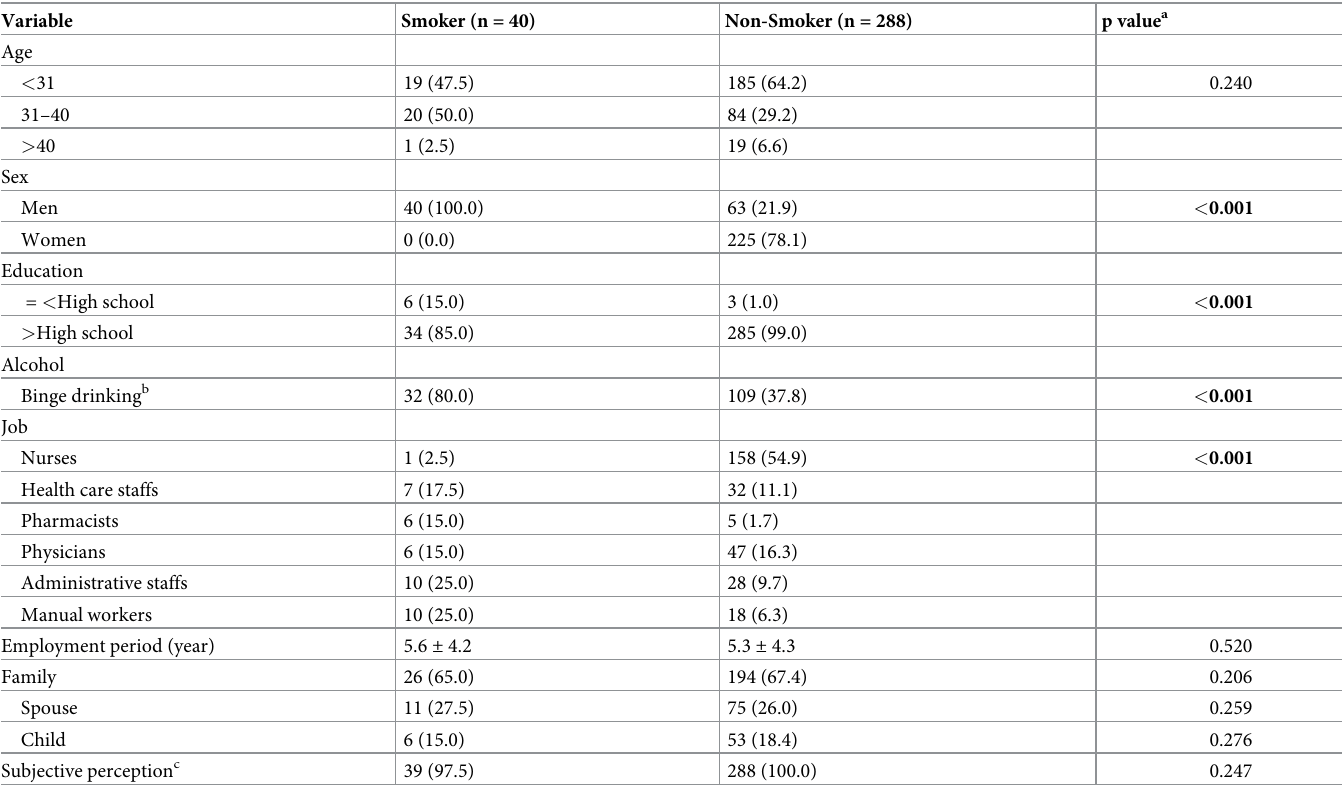
Table 1. Sociodemographic characteristics of